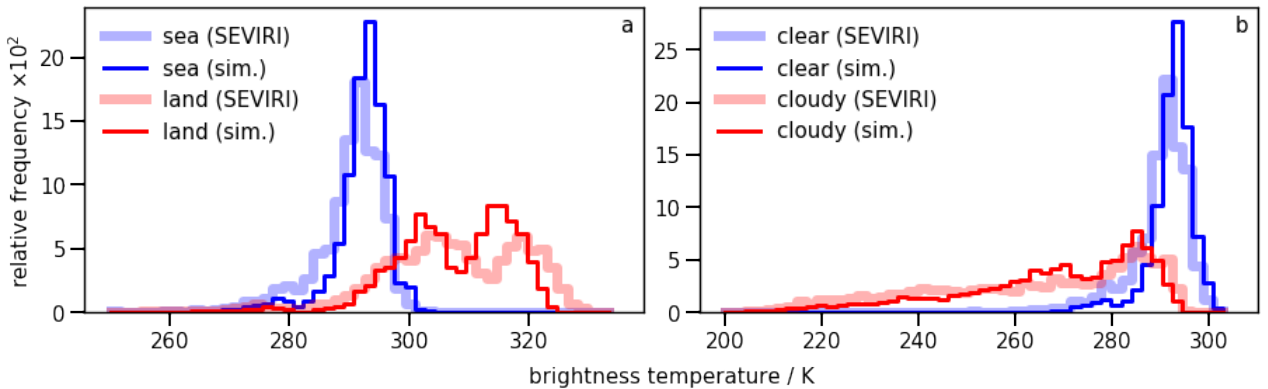
Figure 10. Distributions of the brightness temperature in different MSG/SEVIRI channels as measured from space and as simulated using RTSIM and libRadtran, separated into 50 bins.